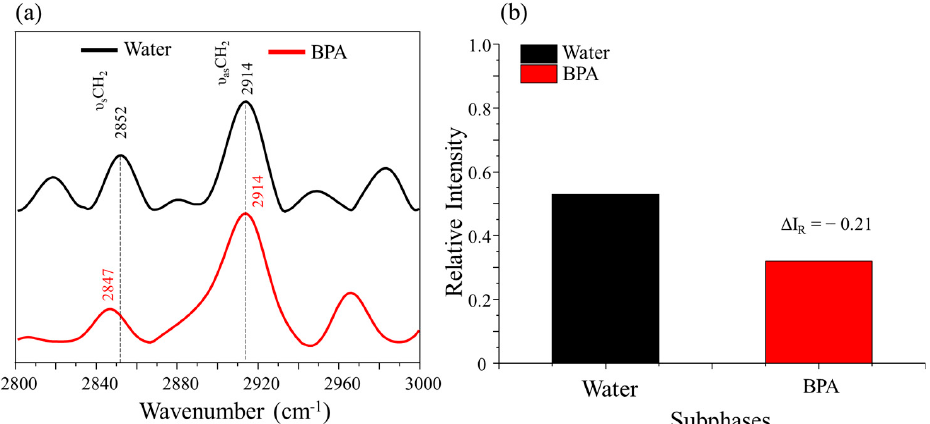
Figure 5. ( a ) PM–IRRAS spectrum from 2800 to 3000 cm − 1 of the DPPC/cholesterol mixture (3:1) in the absence and presence of BPA (1 × 10 − 5 mol/L), obtained at room temperature (23 ◦ C) and surface pressure of 30 mN/m. ( b ) Bar graph of the relative intensities ratio ( ∆ I R ) of the symmetric and antisymmetric CH 2 stretching calculated from PM–IRRAS spectra of DPPC/cholesterol mixture (3:1) in the absence and presence of BPA (1 × 10 − 5 mol/L).